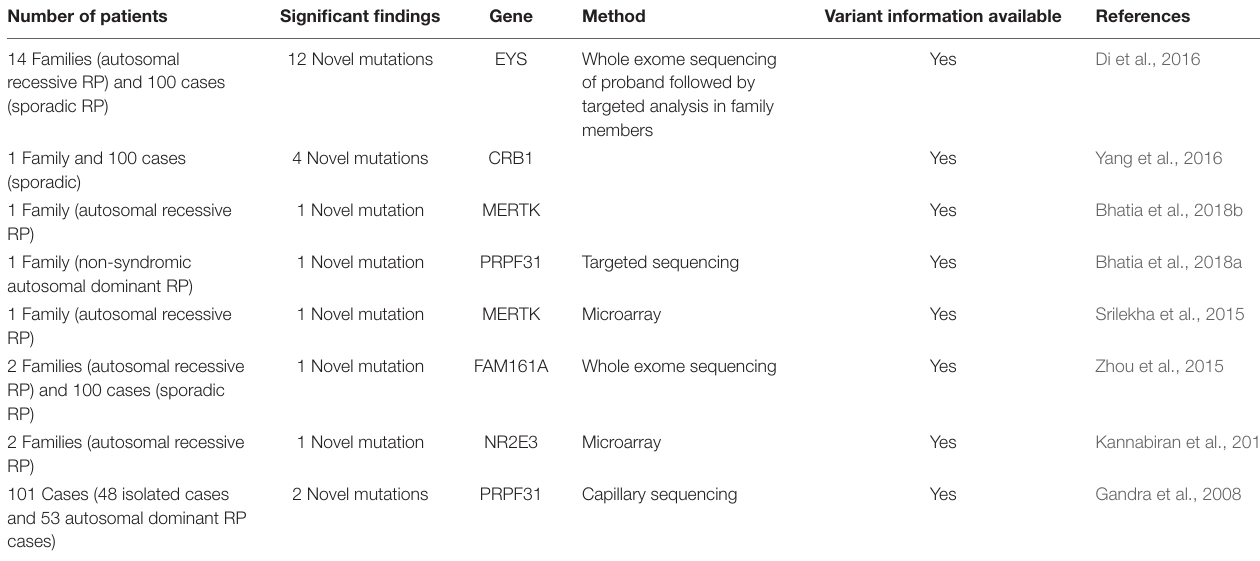
TABLE 1 | Information on summary of mutation studies in Indian RP